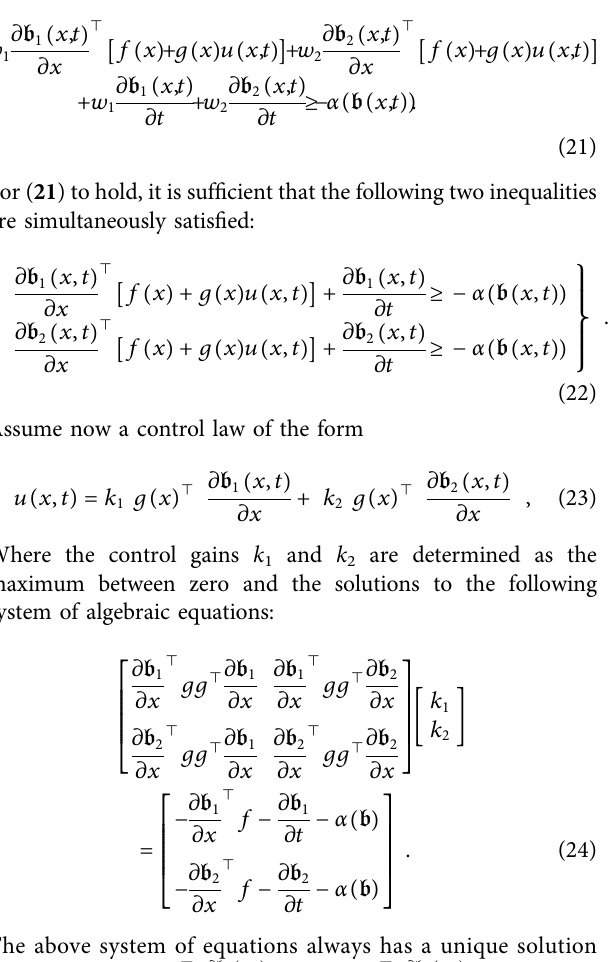
(with equality instead of inequality), and solve for k 1 picking the largest possible value for it. In the case 2 where